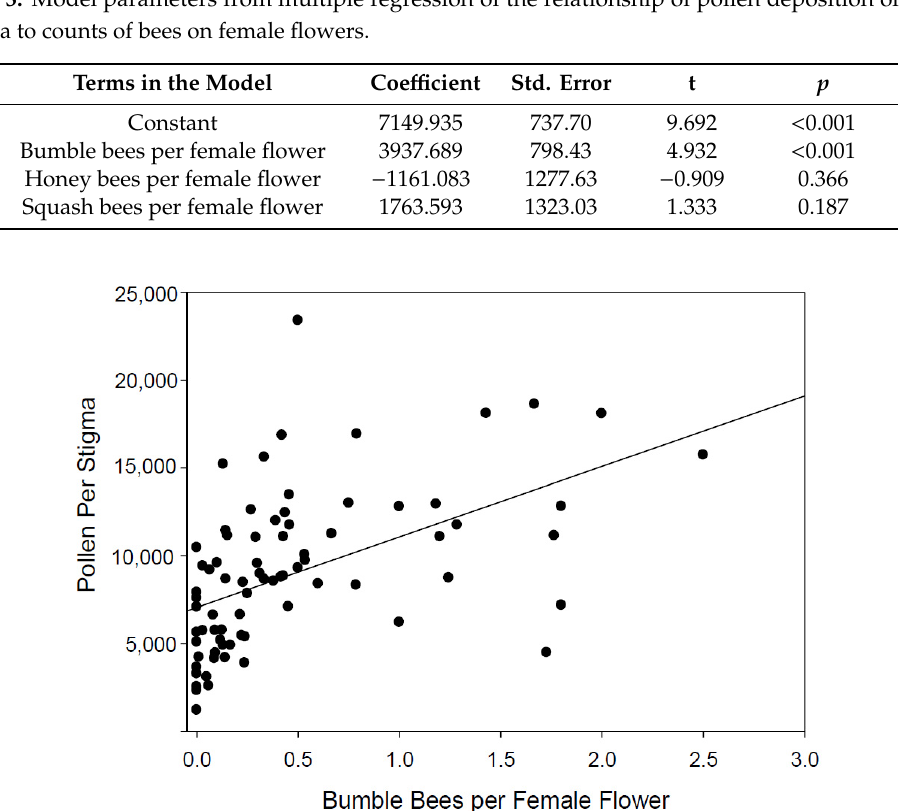
Figure 2. Regression of mean pollen grains per stigma against the number of bumble bees per female flower in hourly 100 flower bee counts 2012–2015 (df = 1, 75; F = 27.123; p < 0.001; adjusted r 2 = 0.26). Equation for line is y = 7059 +